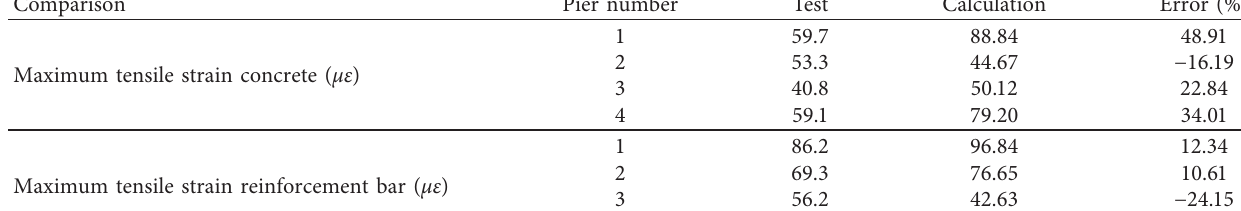
Table 4: Maximum tensile strain of concrete and reinforcement bar at each bottom of the pier for the experimental test and FE model. Comparison